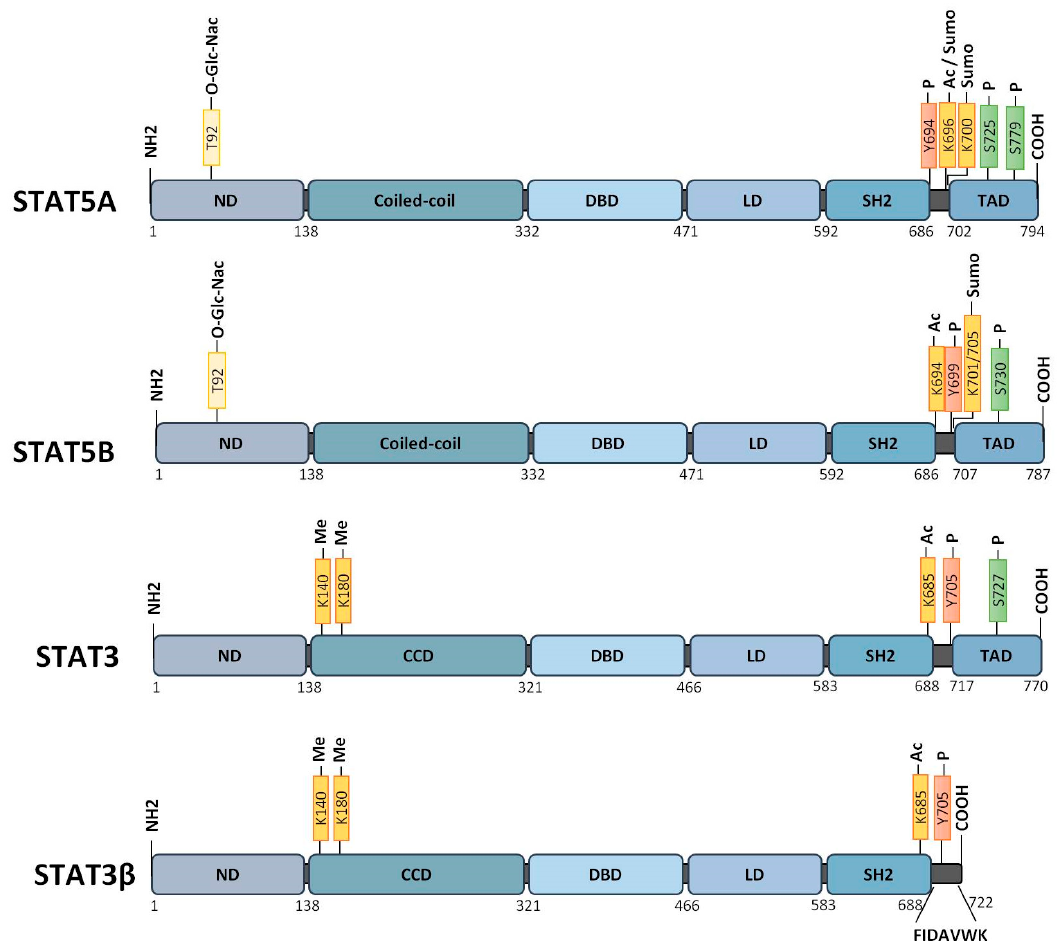
Figure 1. Structure of Signal Transducer and Activator of Transcription (STAT)5A, STAT5B, STAT3, and the spliced isoform STAT3 β proteins. Functional domains: ND, NH2-terminal domain; CCD, coiled-coil domain; DBD, DNA binding domain; LD, linker domain; SH2, Src homology 2 domain; TAD, transactivation domain. Post-translational modifications: Ac, acetylation; Me, methylation; O-Glc-Nac, O-GlcNacylation; P, phosphorylation; Sumo, sumoylation.